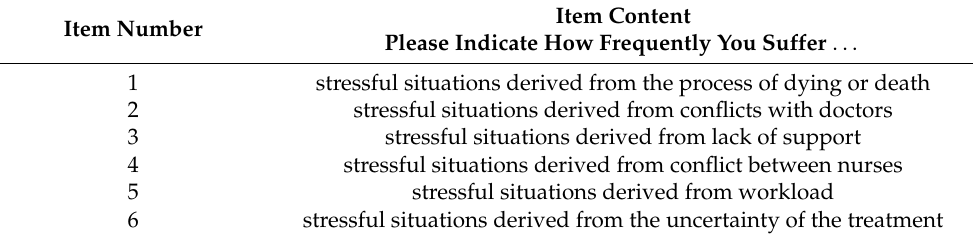
Table 1. The Brief Nursing Stress Scale